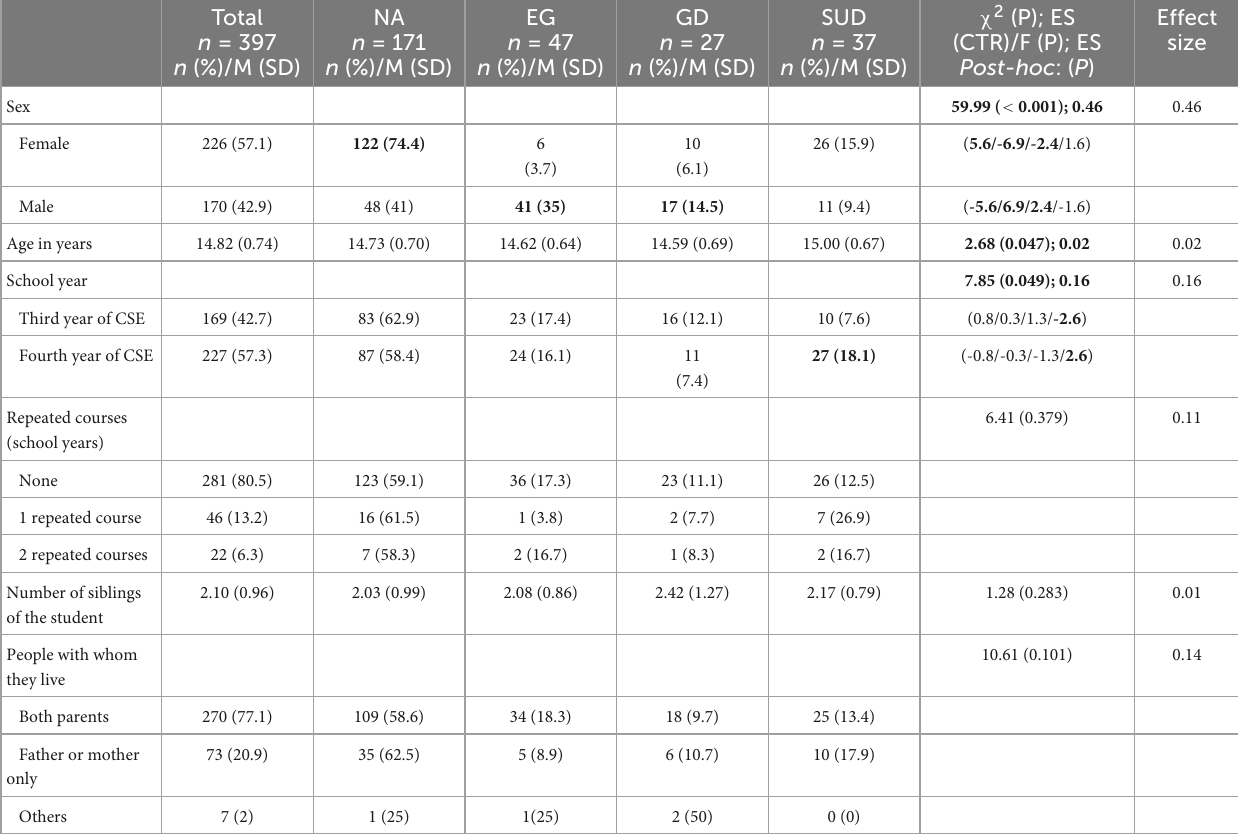
TABLE 1 Descriptive statistics of the sociodemographics of the overall sample and by the no addiction, Excessive Gaming, Gaming Disorder, and Substance Use Disorder